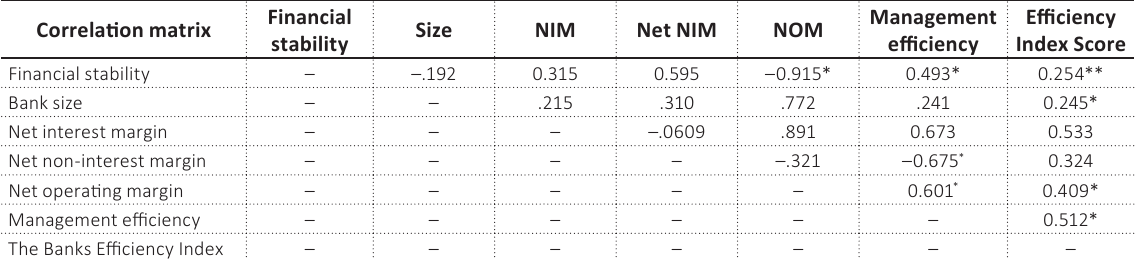
Table 4. Correlation matrix for Model A